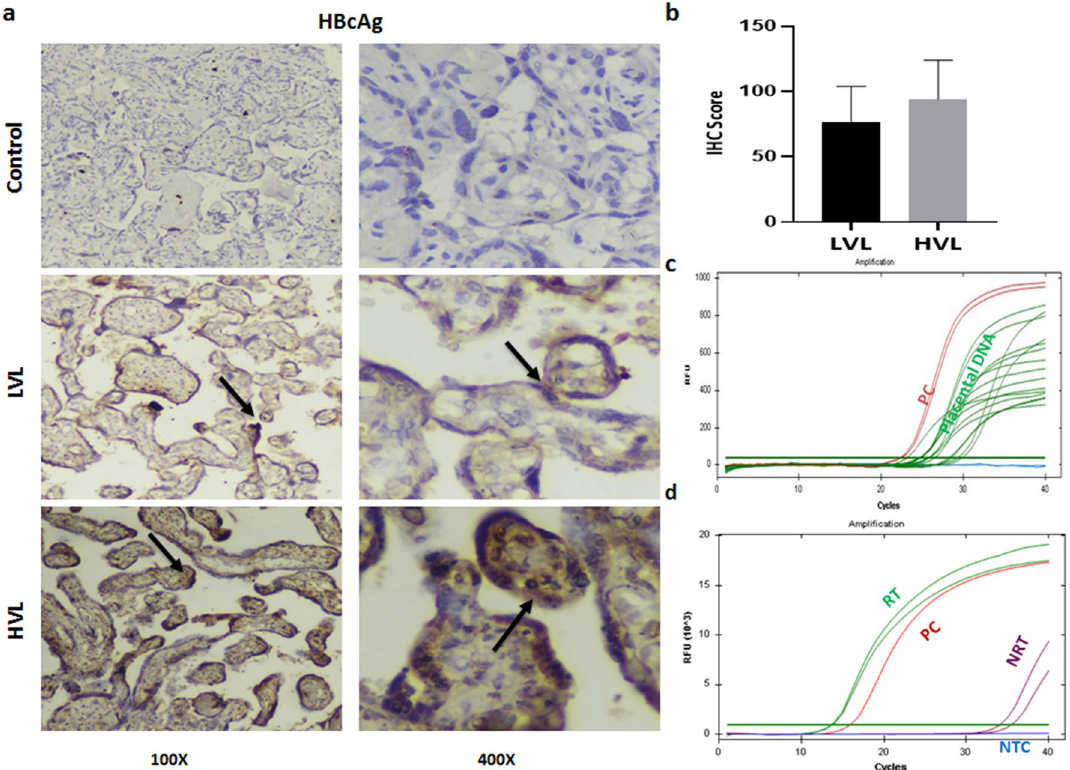
Figure 1. Presence of viral markers in placenta. ( a ) Representative figure showing the presence of HBcAg in placenta detected through Immunohistochemistry (IHC), cytoplasmic staining in LVL and HVL groups was observed, and no staining in control. ( b ) IHC Scores of HVL and LVL groups showed no significant difference (HVL 94.62 ± 9.46 vs. LVL 76.5 ± 8.68 p = 0.9253), p-value was calculated for a risk threshold α = 0.05, p* < 0.05. ( c ) Detection of total HBV DNA in placenta through qPCR amplification and ( d ) detection of pre-genomic RNA in placenta through qRT-PCR amplification. HVL High Viral Load Group, LVL Low Viral Load Group, PC Positive Control, NTC No Template Control, RT cDNA prepared with Reverse Transcriptase, NRT cDNA prepared without Reverse